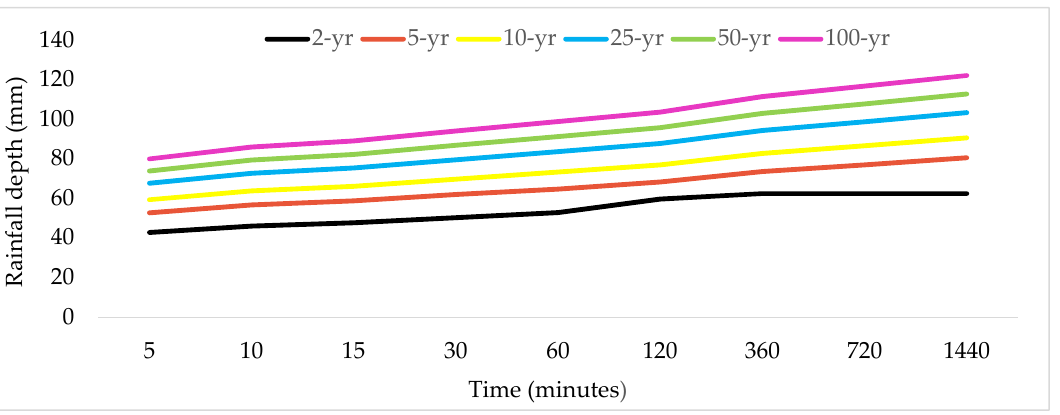
Figure 6. Rainfall depth at different durations (minutes) estimated from Gumbel’s extreme value distribution and Ethiopian Roads Authority for Hawassa city.